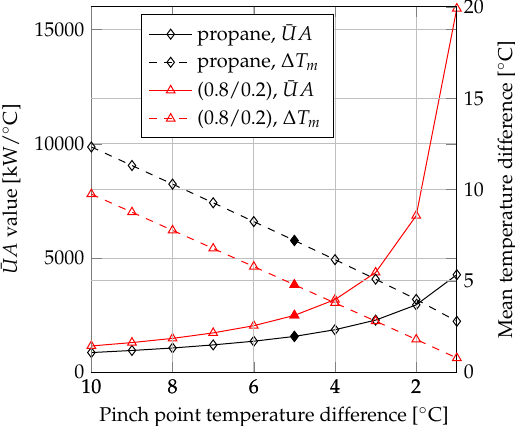
Figure 5. Condenser ¯ UA and mean temperature difference versus pinch point temperature